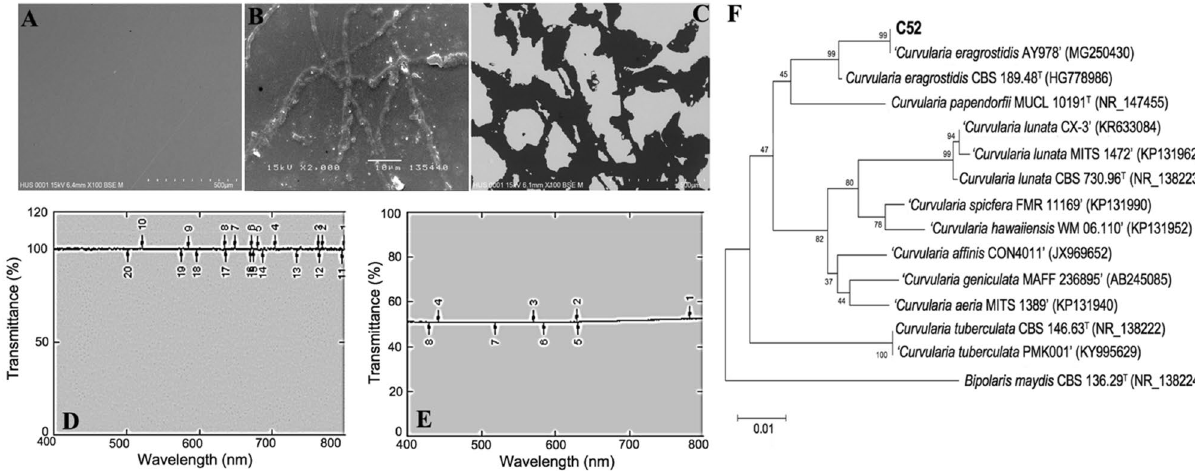
Figure 1. Glass biodeterioration ability and identification of fungal strain C52. Comparison of SEM images of the control ( A ), glass treated by fungal strain C52 before ( B ), and after the cleaning procedure ( C ). Light transmission detected in untreated ( D ) and fungus-treated glasses ( E ). ( F ) Phylogenetic tree based on the ITS gene sequences of C. eragrostidis C52 and its related strains.